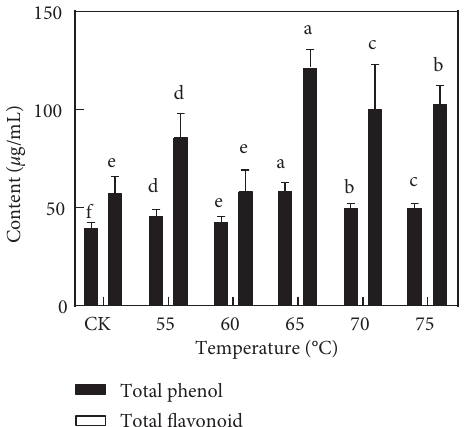
Figure 4: Total phenol and favonoid content of “Yali” pear paste prepared under traditional and vacuum concentrations with dif- ferent temperatures. CK: pear paste under traditional heating concentration; 55 ° C, 60 ° C, 65 ° C, 70 ° C, and 75 ° C: pear paste at diferent vacuum concentration temperatures; diferent letters indicated signifcant diferences among groups ( p < 0 .